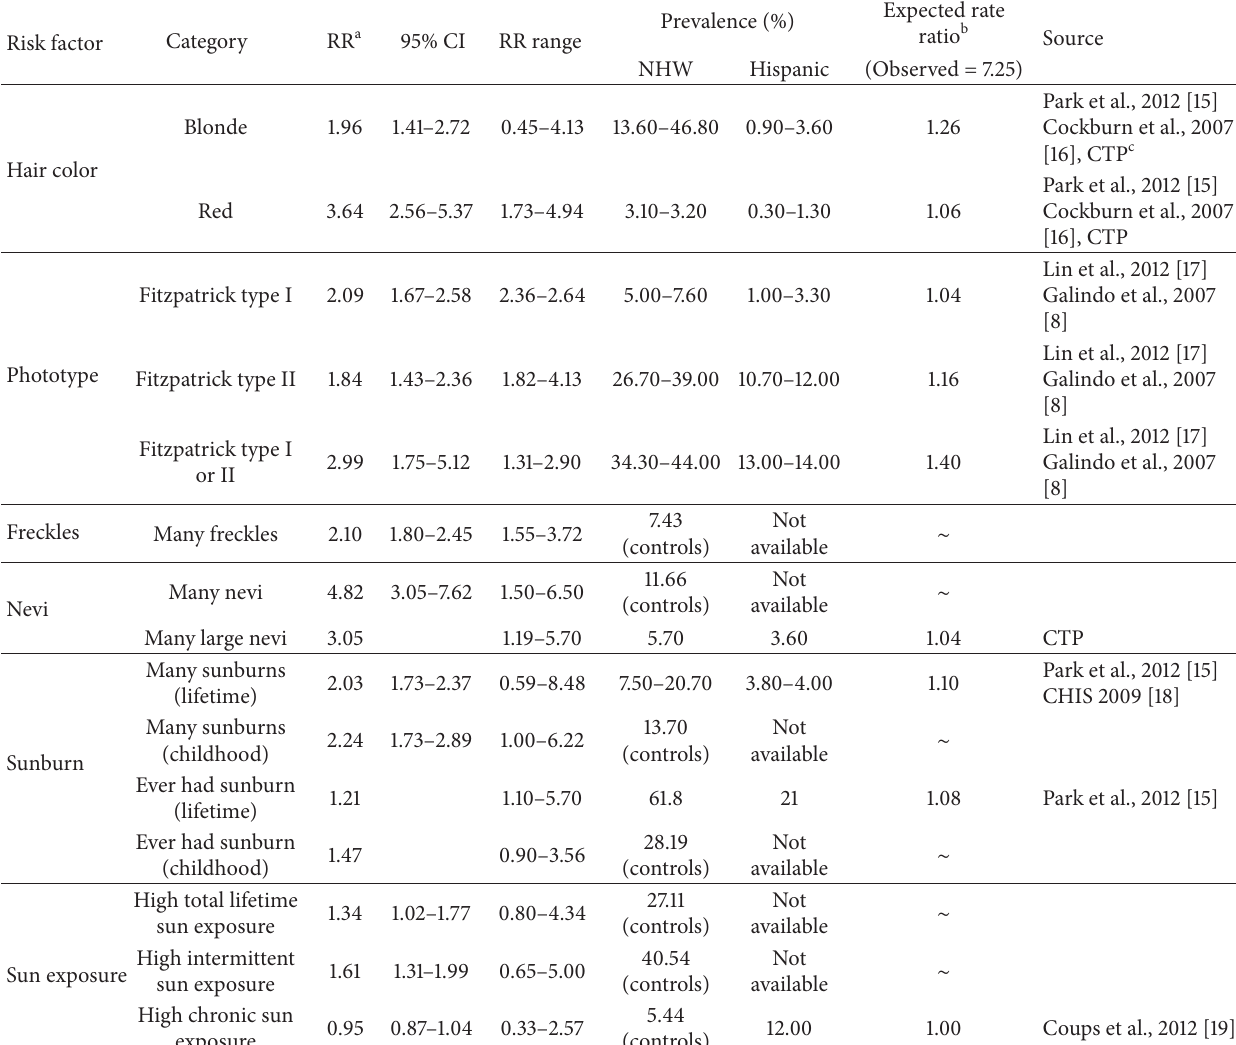
Table 1: Summary of relative risks (RR) and prevalence of risk